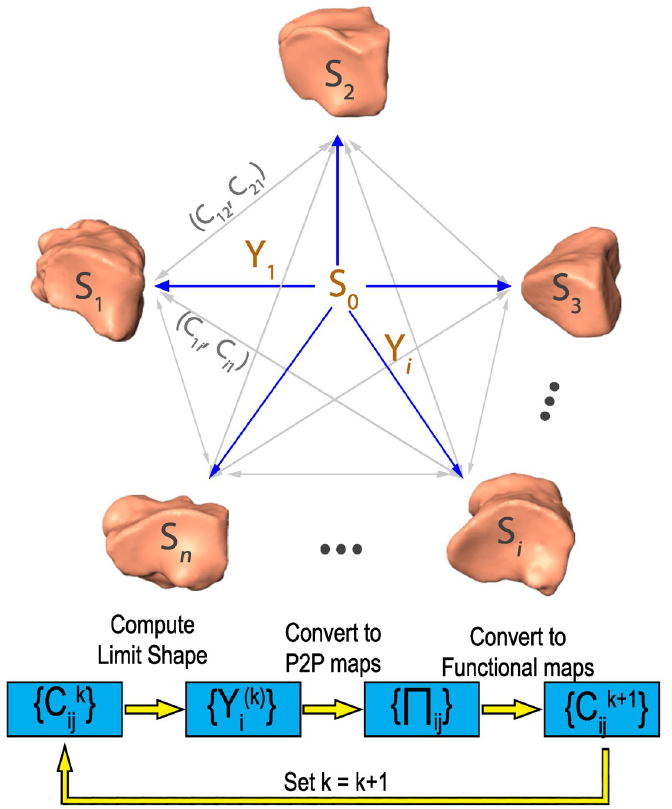
Fig 12. Limit Shape and consistent ZoomOut Illustration. Given a shape collection, Limit Shape S 0 is the “mean” shape considering all the shape variation within this shape collection via Y shape S and S . The bottom pipeline indicate the way Consistent ZoomOut is performed to refine the functional maps i j through a joint work of 1. Limit Shape Recomputing; 2. P2P map conversion given the new Limit Shape; 3. Convert back to functional maps from P2P